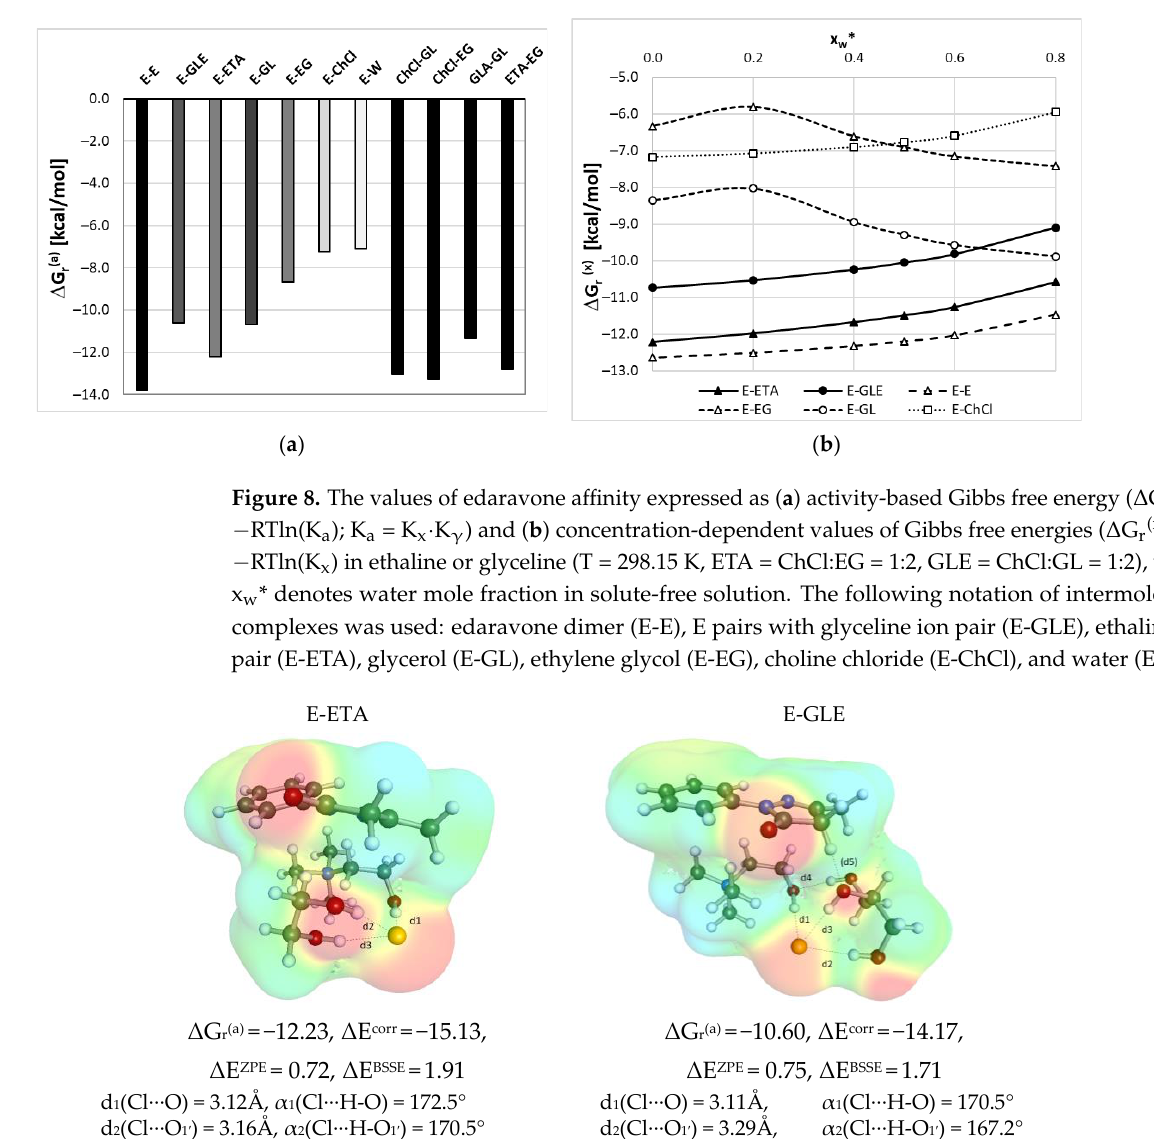
Figure 7. The most important geometric and energetic properties of intermolecular complexes iden- tified in ETA and GLE. All thermodynamic contributions are expressed in kcal/mol and represent relative values for X + Y = XY reactions, Δ G r(a) = the concentration-independent value of Gibbs free